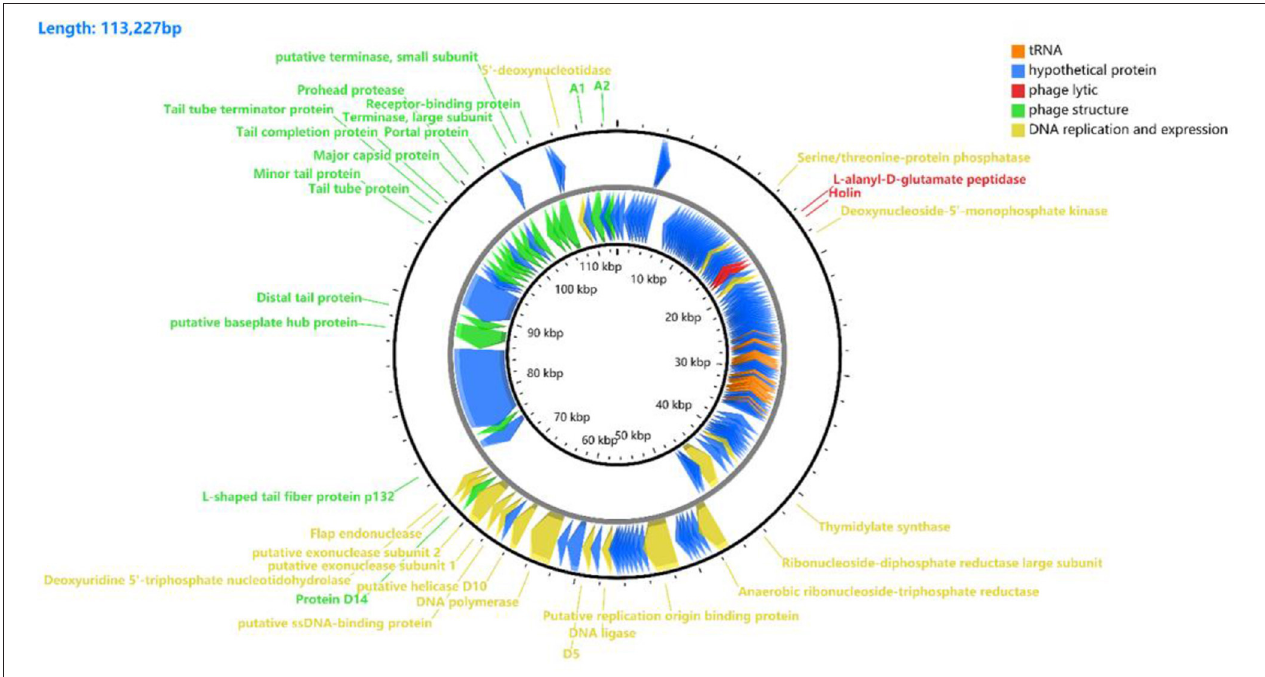
FIGURE 4 | Gene functional annotation of vB_Kpn_B01. The arrow represents the direction of the gene, and the color represents different domains of functional genes: red, lyase-related genes; orange, tRNA; yellow, DNA replication and gene expression genes; green, structural protein genes; blue, hypothetical protein genes.